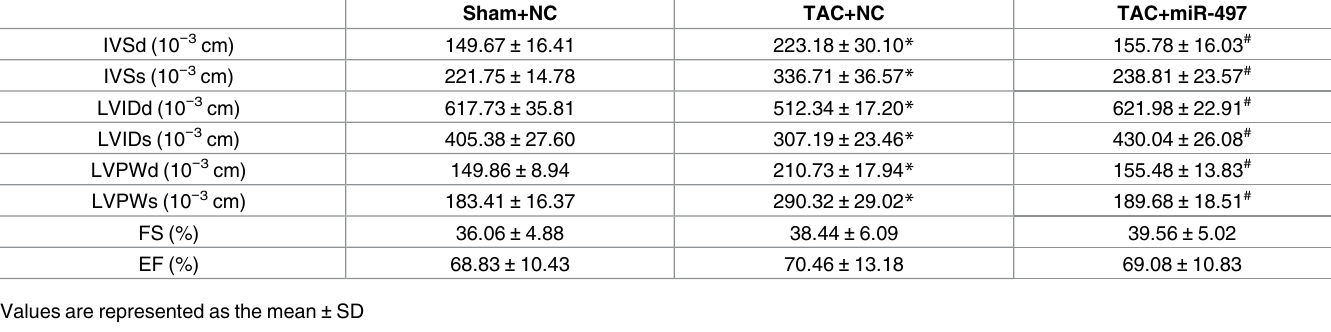
Table 1. Cardiac structure and systolic function.